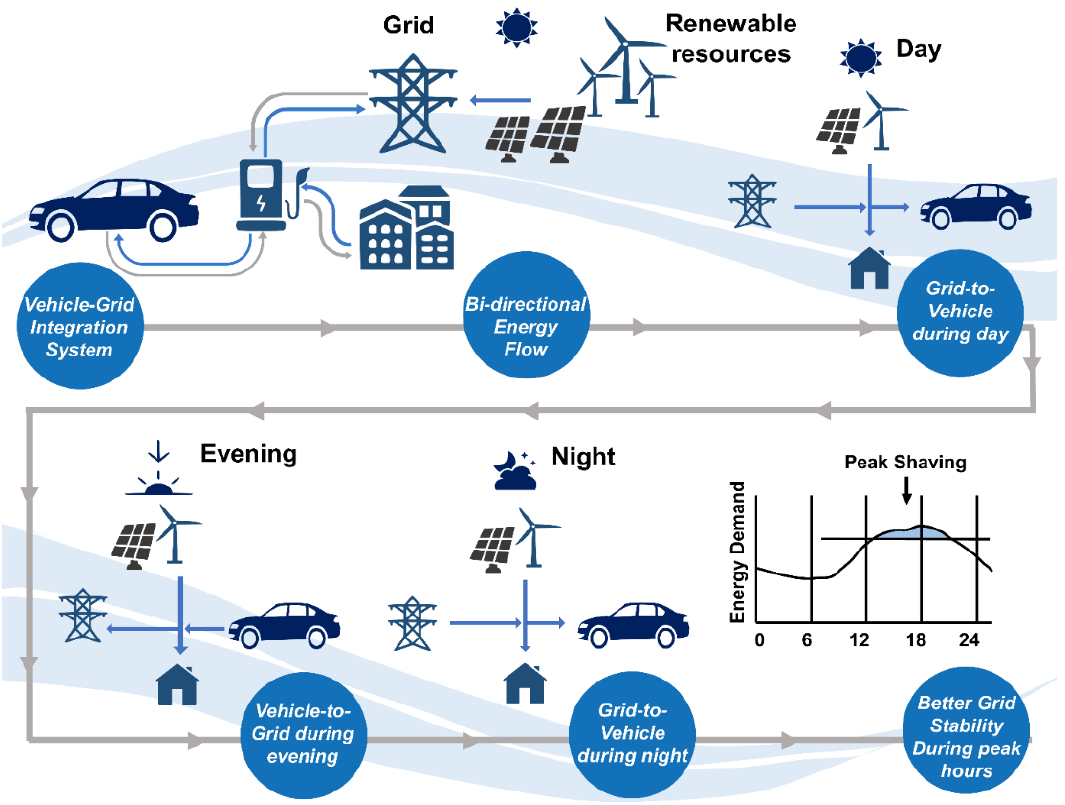
Figure 1. An illustration of the V2G concept during different times of the day. The graph shown in the figure is only for illustrative purposes (redrawn from [7].)